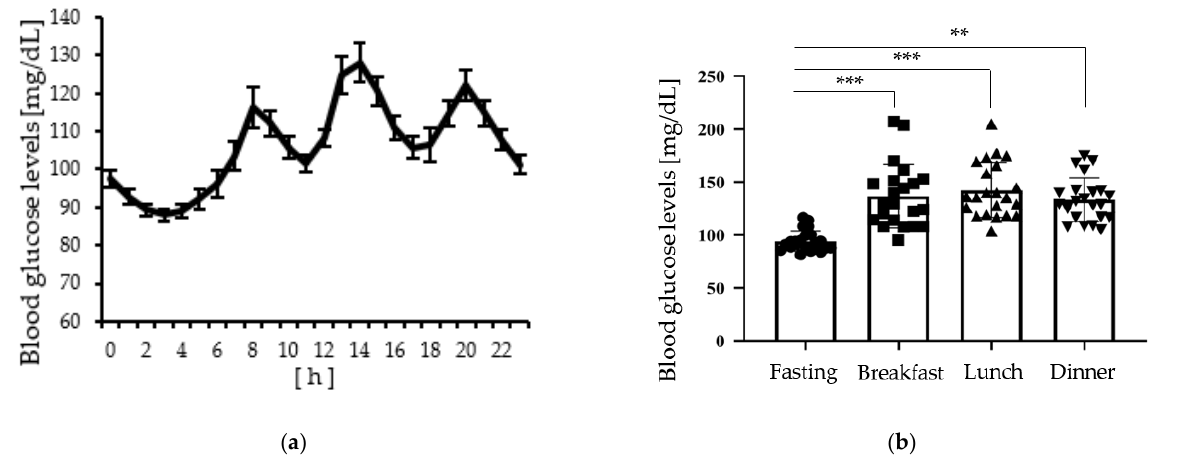
Figure 1. ( a ) Changes in the blood glucose levels for 24 h ( n = 22). Values are expressed as means and standard errors; ( b ) Comparison of blood glucose levels fasting (1 point before breakfast) and peak